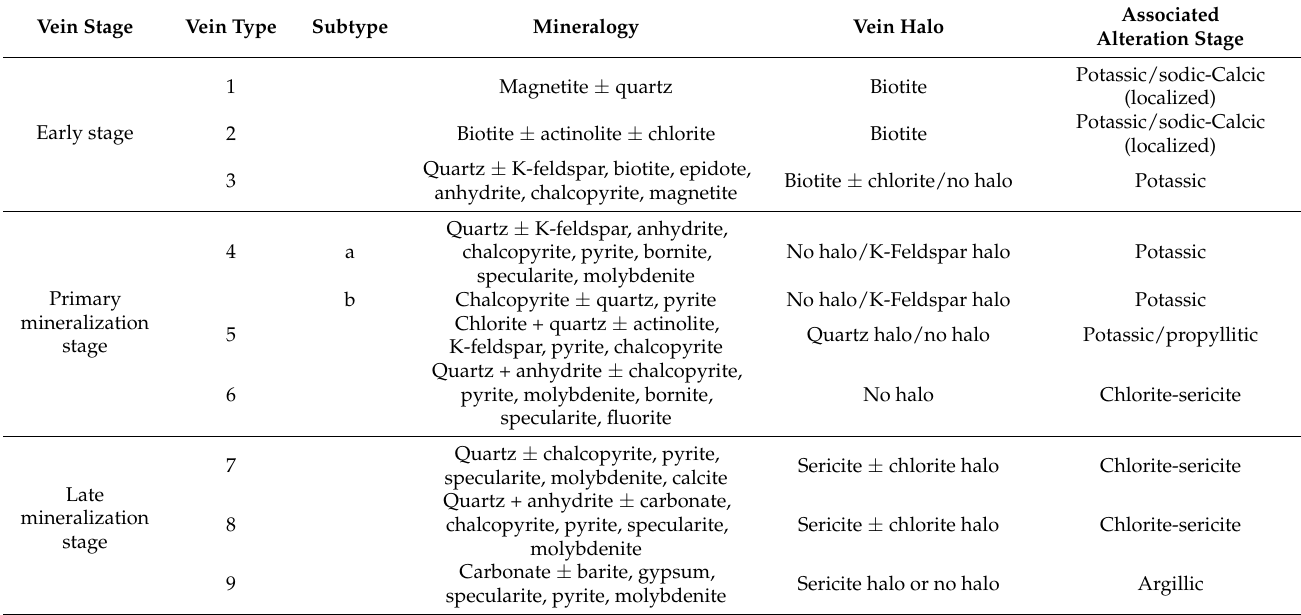
Table 2. Don Manuel vein types and